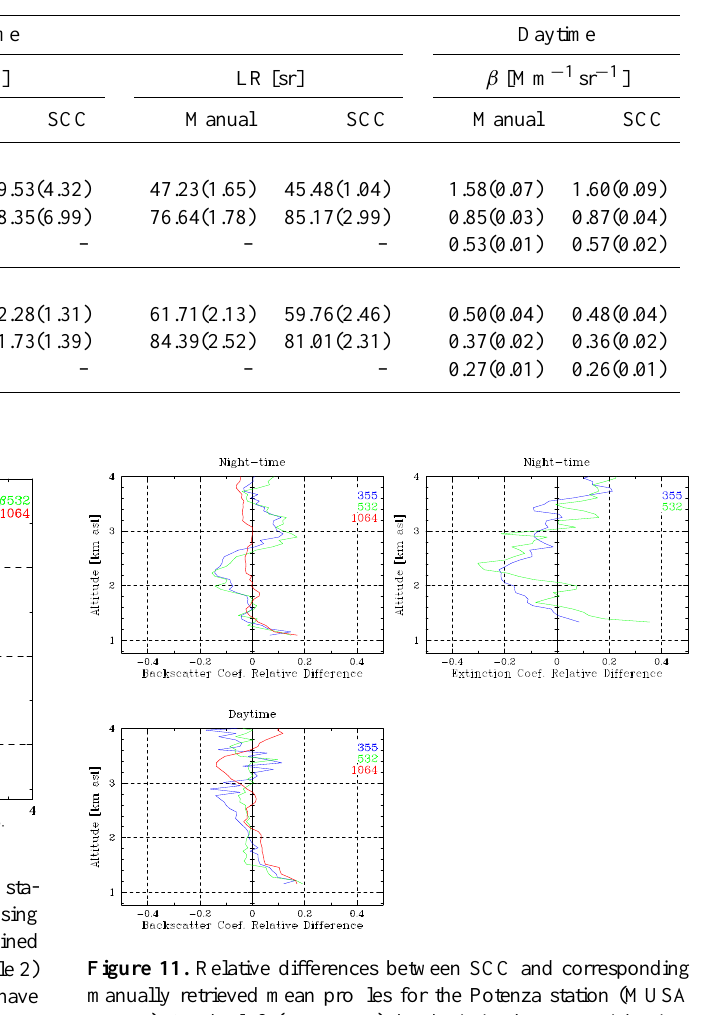
Table 3. Comparison of the mean values and standard errors of the mean for the profiles of the Potenza station shown in Figs. 9 and 10. Mean values and standard errors of the mean (reported in parentheses) were calculated by averaging the mean profiles within Range 1 (0–2km) and Range 2 (2–4km).